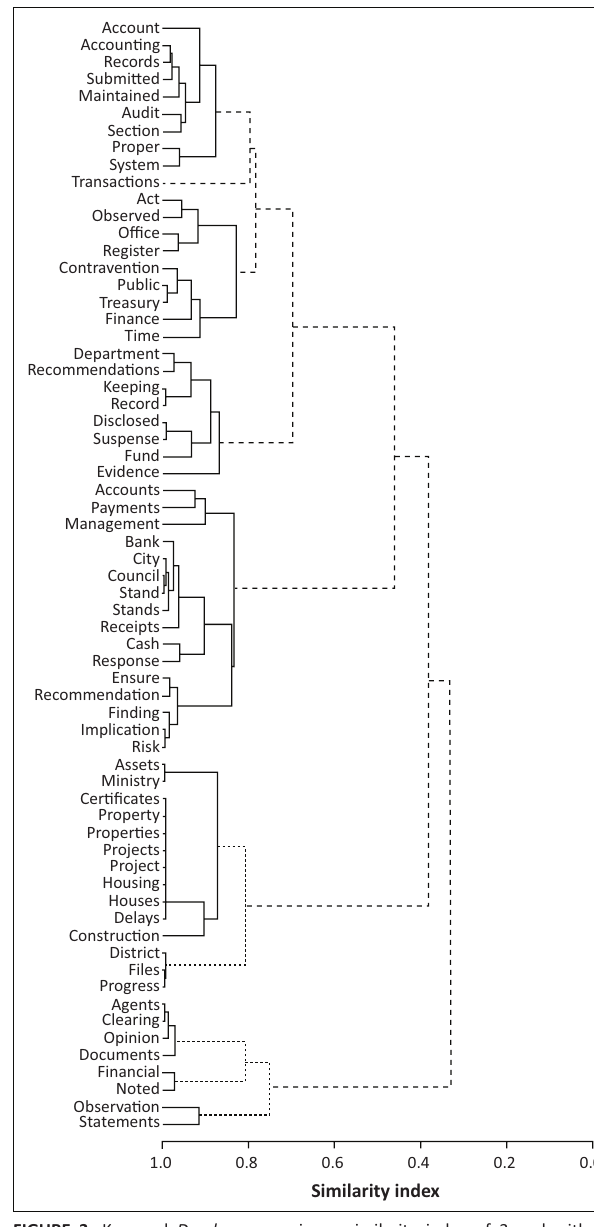
FIGURE 3: Keyword Dendrogram using a similarity index of 3 and with 10 clusters.